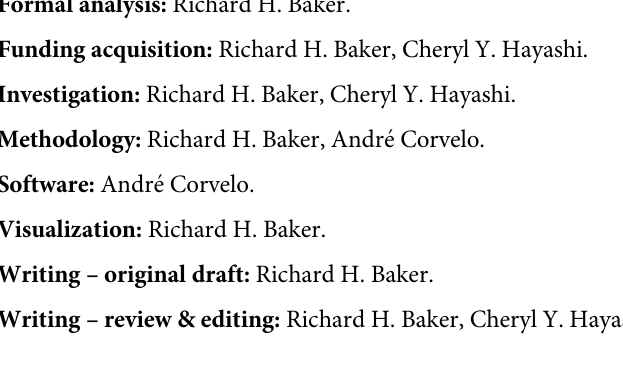
S6 Table. Ensemble repeat structure of MaSp1 and MaSp3 genes. ’ER size’ indicates the most common ER in terms of number of poly-A units. ’ER regularity’ provides the proportion of total ER units that have the most common size (e.g., a value of 1 means all ER units are the same size). ’Ave %_ID’ indicates the average percent amino acid identity for homologous poly- A units across all ER units.’% Repeat’ indicates the percentage of the total protein occupied by stereotypical ER units. S7 Table. MaSp replicate gene expression. TPM values of tissue replicates for all MaSp genes. Each species’ values are presented in a separate tab. S1 File. Amino acid translations of all Argiope MaSp gene coding regions. S2 File. MaSp repeat structure. Poly-A containing Argiope MaSp proteins broken down by poly-A units. In most genes, ensemble repeats are evident as a repeating set of poly-A units of stereotypical size. Linker regions in MaSp3 genes presented as lowercase residues. S3 File. Alignments of sequence data used to generate trees in